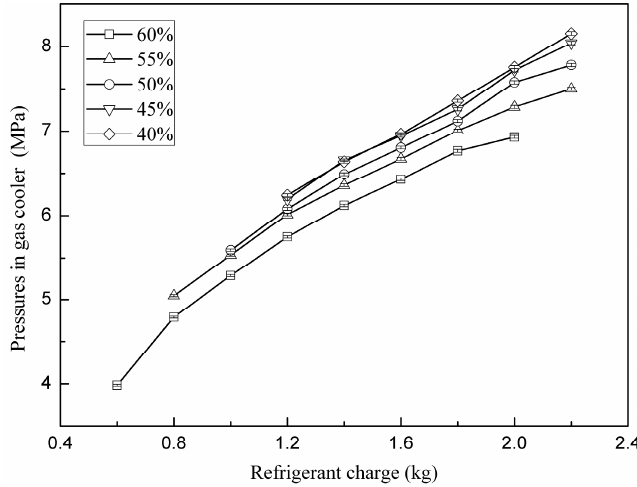
Figure 8. Variations of the pressures in gas cooler with refrigerant charge and EEV opening.